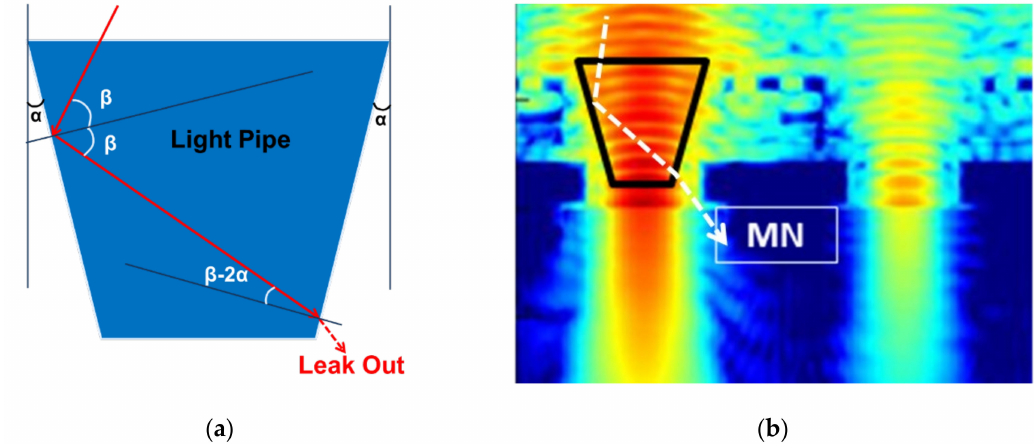
Figure 6. Schematic of reflection: ( a ) explanation of incident angle and ( b ) conceptual simulation